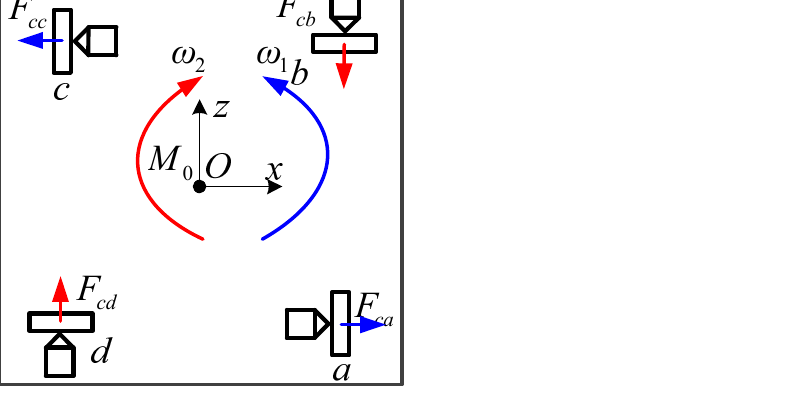
19 of 28 Figure 20. Schematic diagram of the orientation layout of the capture hooks. The positioning shaft of each passive end has two layout directions, parallel to either the x -axis or the z -axis. Thus, there are K p = 2 4 = 16 possible layouts for the four positioning shafts. Since the locking hook of each active end can only move along the positive and negative directions of the x -axis and the z -axis during capture, it will cause the payload to rotate after generating torque M i . The number of possible layouts for the hooks also amounts to K d = 2 4 = 16, and if all possible combinations for the hooks and positioning shafts are considered, 256 layouts would need to be analyzed. However, the classification can be simplified to reduce unnecessary work and improve simulation efficiency. The payload base plate has square symmetry, so the layout of the positioning shafts can be simplified into K p (cid:48) = 4 layouts, as shown in Figure 21.